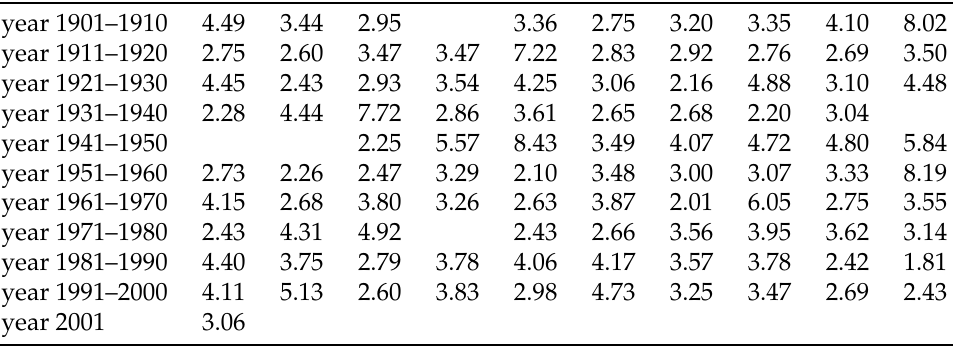
Table 10. Annual maximum daily rainfall (inches) for Orlando (1901–2001).